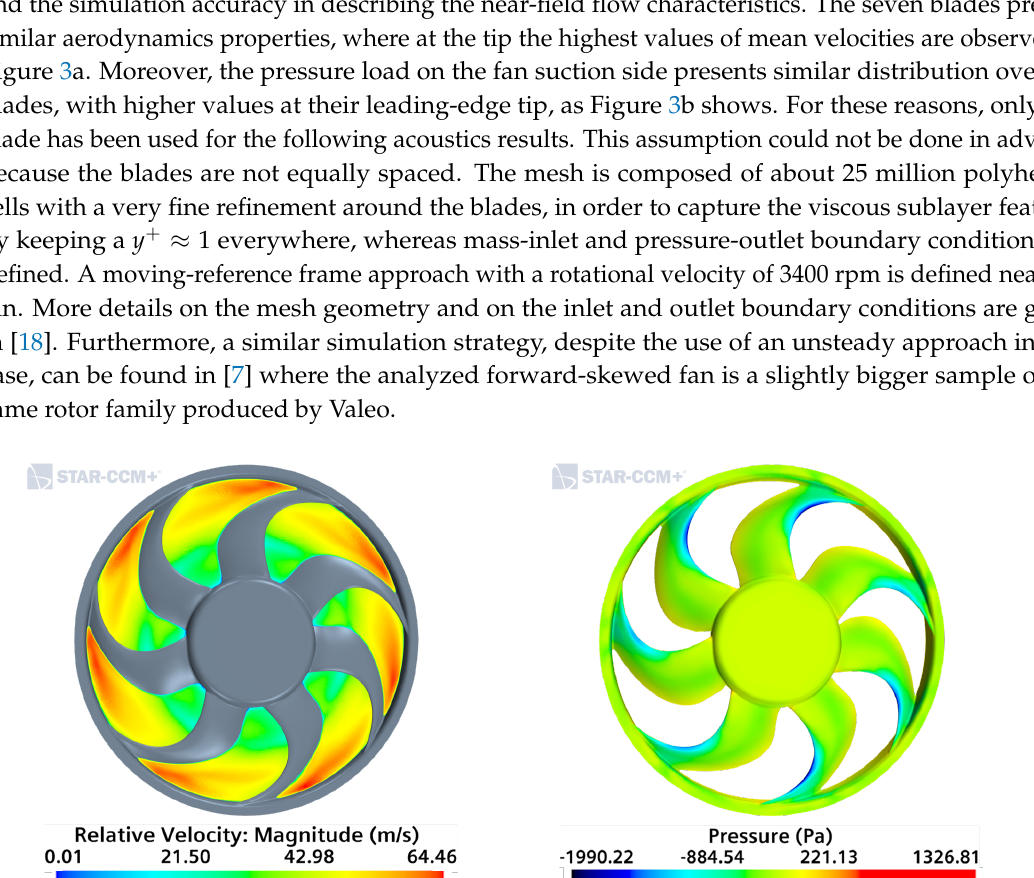
The RANS-based numerical results show similar azimuthal features over the 7 non-equally-distributed fan blades, making it possible to deal with them separately: in ( a ), the relative velocity is illustrated on a plane normal to the fan rotating axis, showing higher velocities at the blade trailing-edge tips; in ( b ), the distribution of pressure indicates that the most loaded zones are the blade leading-edge